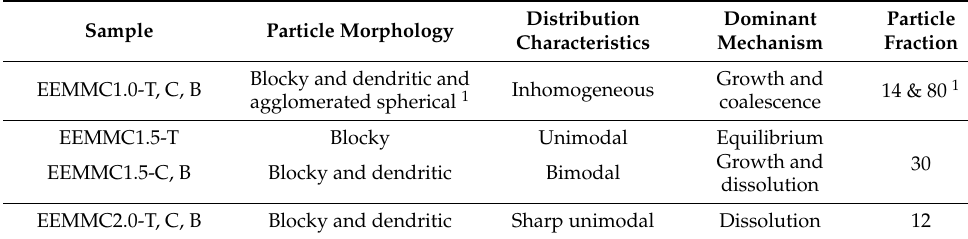
Figure 10. EPMA results for ( a ) EEMMC1.5-T and ( b ) EEMMC2.0-T. Table 4. Morphology, fraction, and formation mechanism of reinforcing